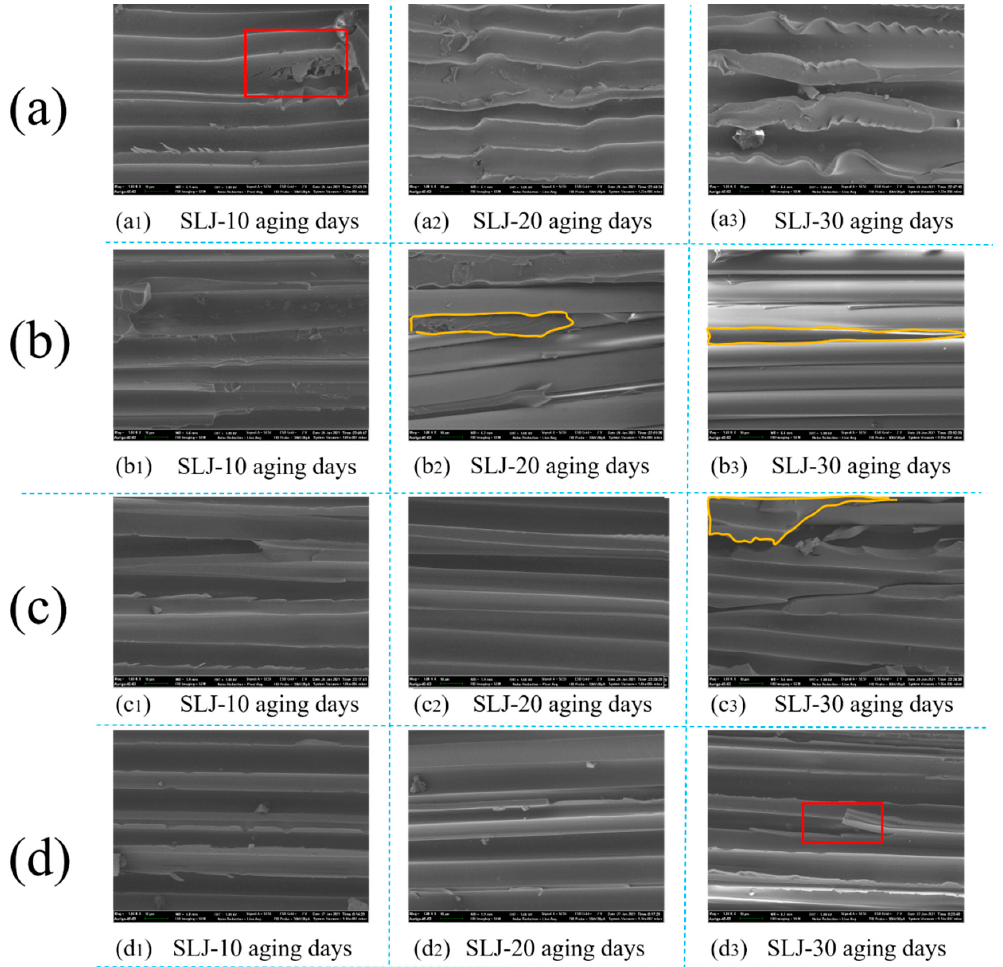
Figure 13. The SEM micrograph of different adhesive joints in different environments: ( a ) Araldite®2012 joints in 80 °C/95%RH, ( b ) Araldite®2012 joints 80 °C/pure water, ( c ) Araldite®2014 joints in 80 °C/95%RH, and ( d ) Araldite®2014 joints 80 °C/pure water.